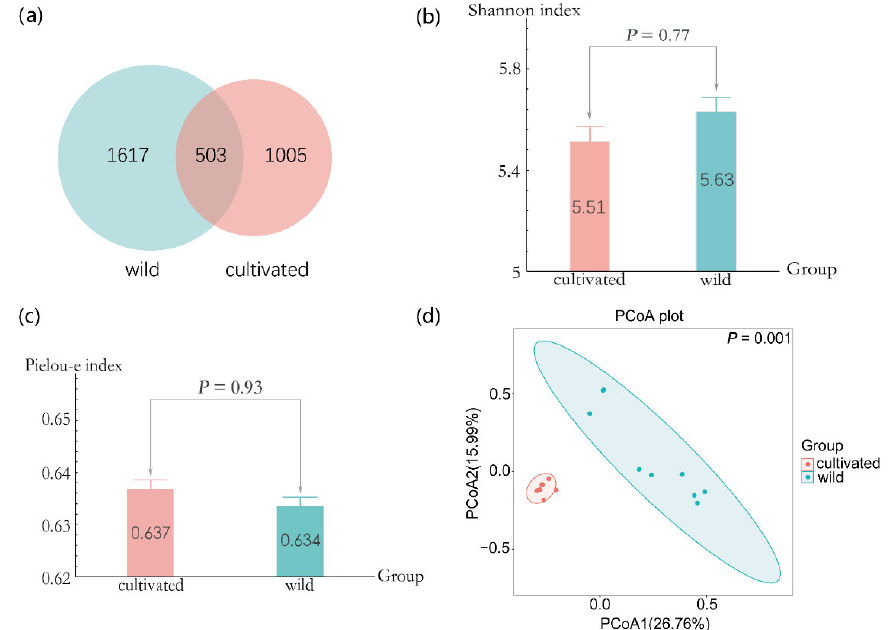
Figure 2. Alpha diversity and beta diversity of L. delavayi leaves. ( a ) Venn diagram of endophytic fungi in wild and cultivated L. delavayi leaves. ( b ) The Shannon index of the fungal community for wild and cultivated L. delavayi leaves. ( c ) The Pielou-e index of fungal community for wild and cultivated L. delavayi leaves. ( d ) PCoA analysis of endophytic fungal community in wild and cultivated L. delavayi . The percentage of the horizontal and vertical coordinates represents the degree of interpretation of the sample difference for the first axis and the second axis, respectively. The analysis is based on Bray–Curtis distance matrix.